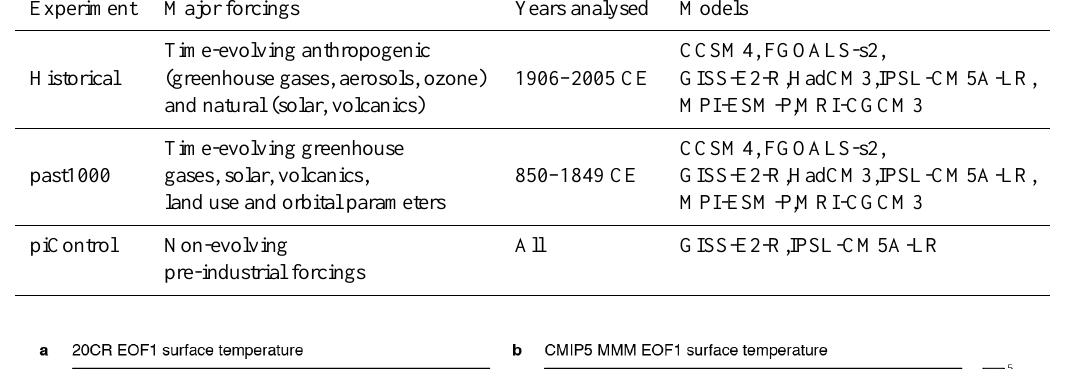
Table 1. Details of CMIP5 experiments and models analysed. Further details can be found through the Program for Climate Model Diagnosis and Intercomparison (PCMDI).